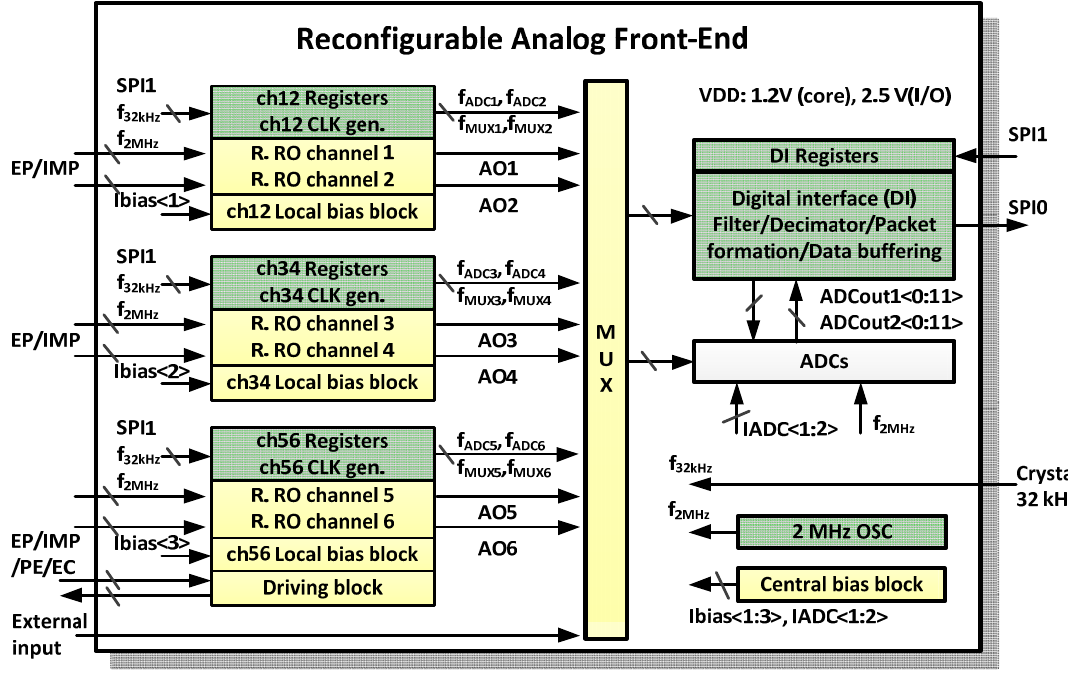
Figure 3. Top overview of the reconfigurable analog front-end (AFE).